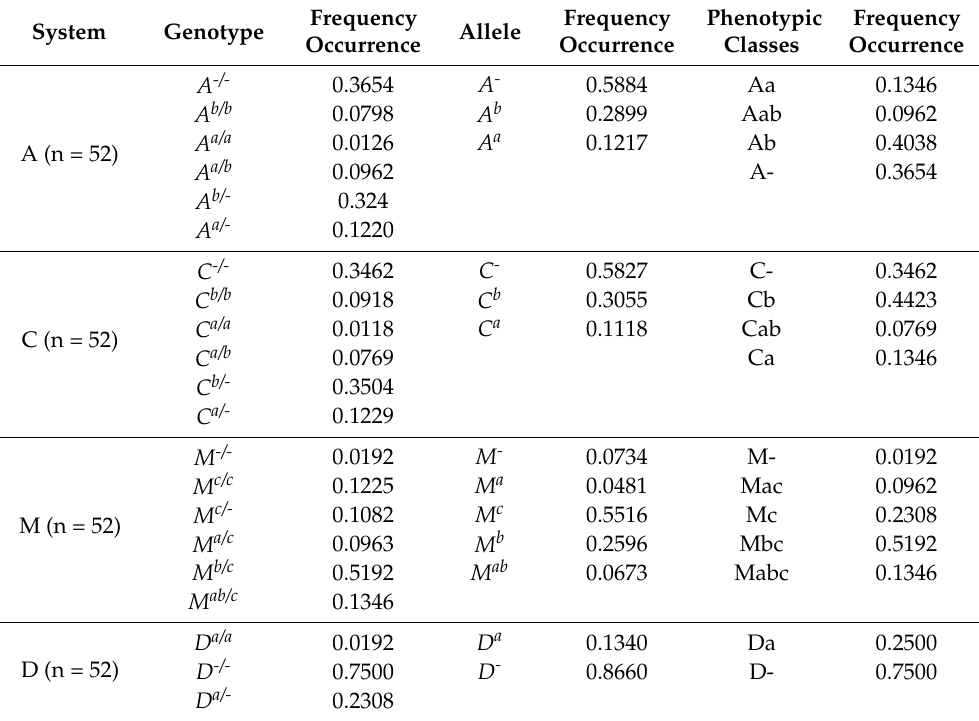
Table 1. Frequency of genetic factors of 6 systems of blood groups in the Romanov